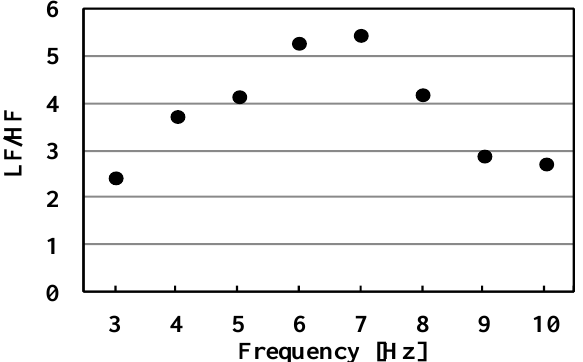
Figure 10. LF/HF values in each vibration frequency (amplitude: 1.5 m/s 2 ).